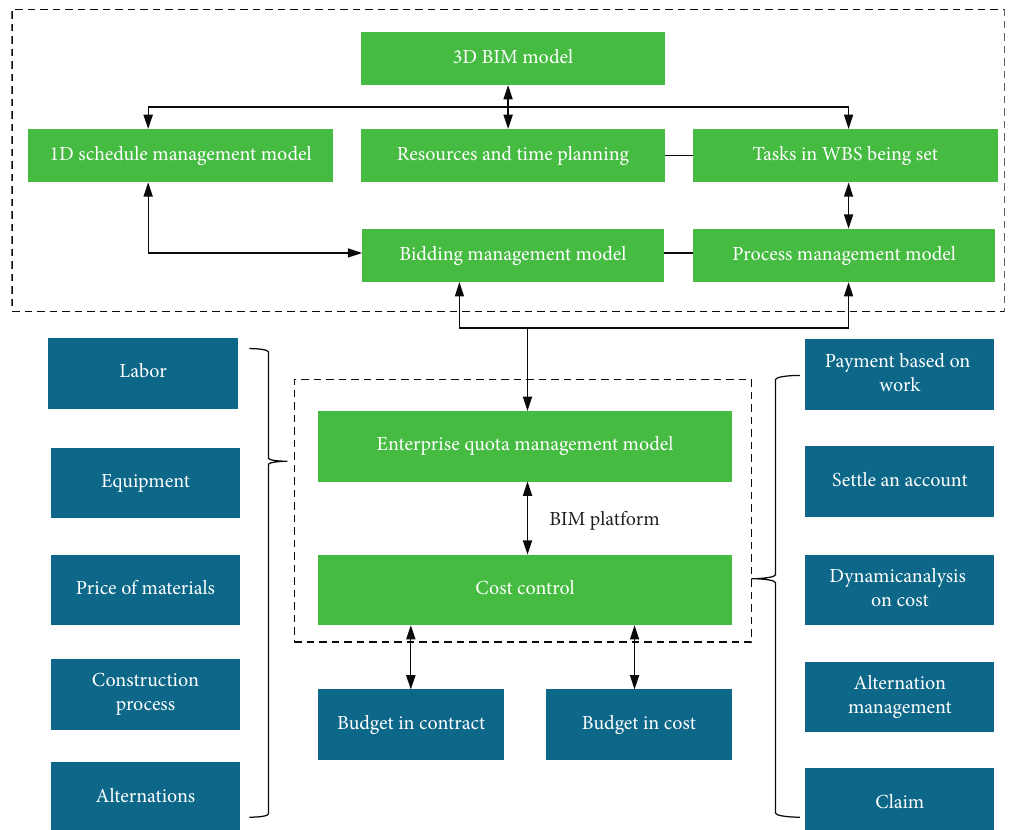
Figure 6: Flow chart of enterprise quota management